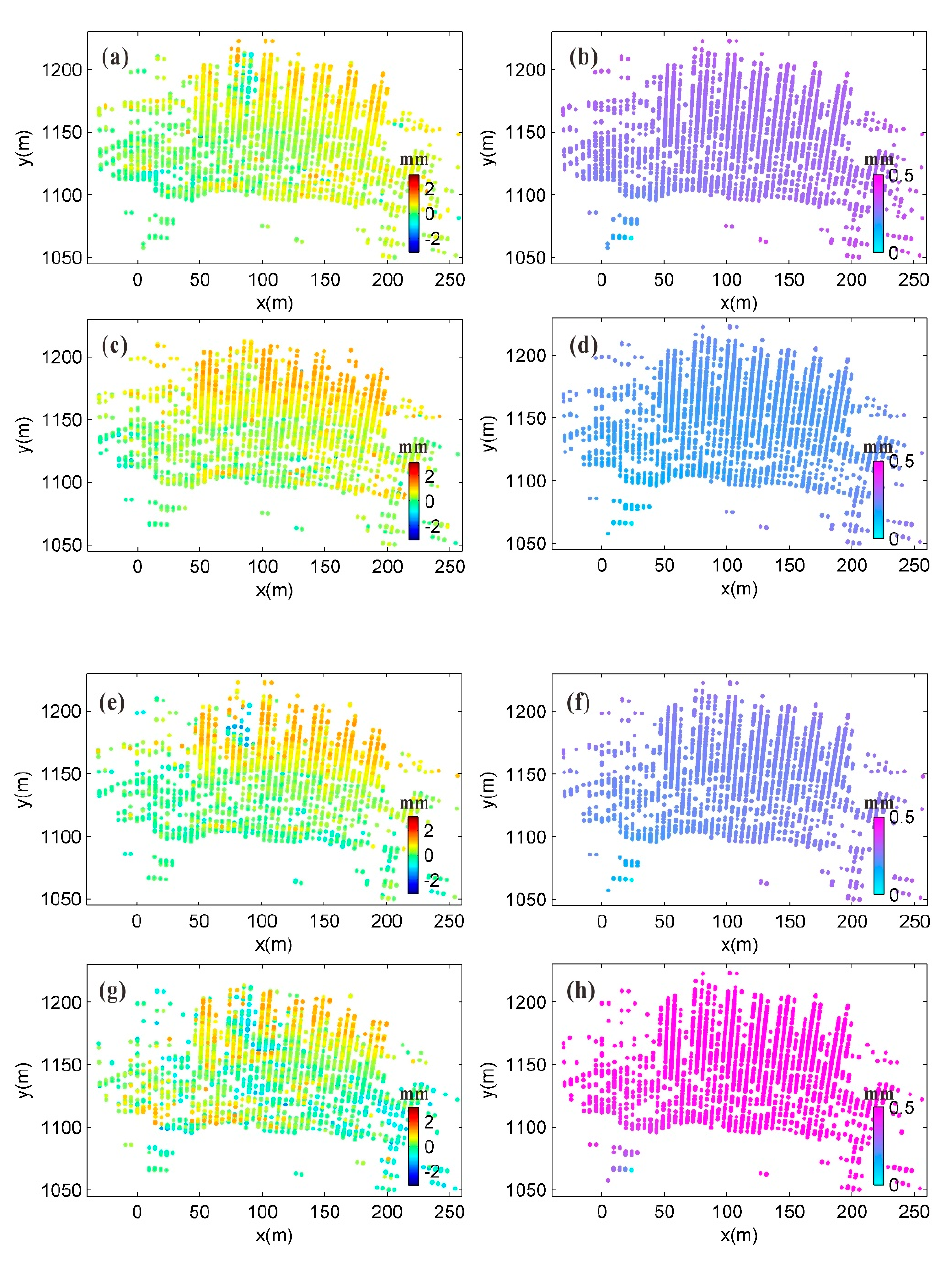
Figure 10. Cumulative deformation and corresponding GB-SAR calculation accuracy for each of four time periods: ( a ), ( c ), ( e ), and ( g ) show cumulative deformation for periods S1–S2, S1–S3, S1–S4, and S1–S5, respectively; ( b ), ( d ), ( f ) and ( h ) show estimated standard deviation in cumulative deformation for periods S1–S2, S1–S3, S1–S4, and S1–S5, respectively.